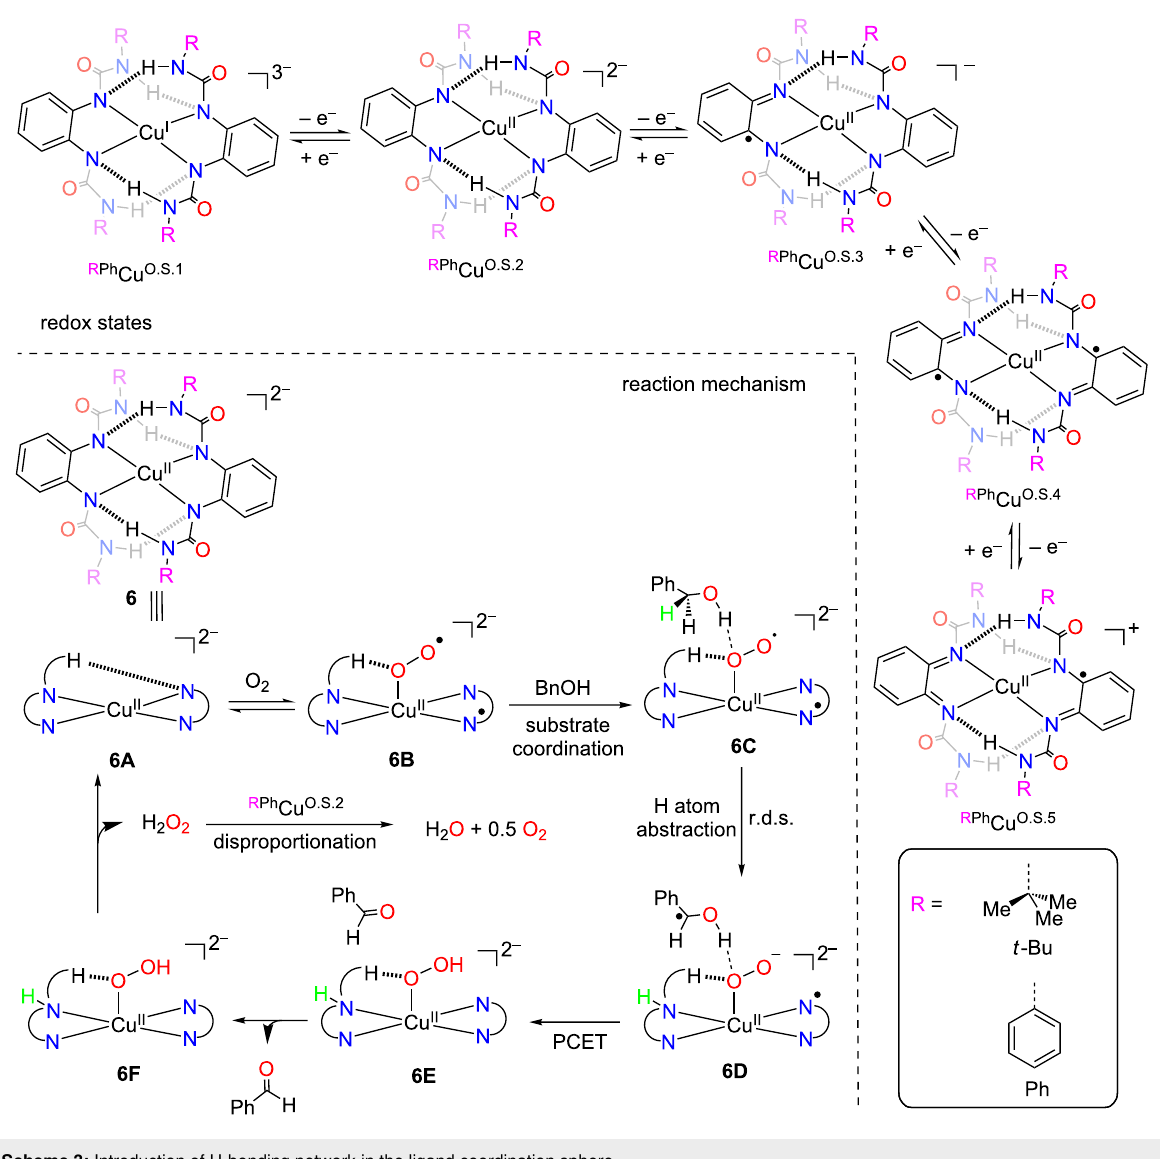
Scheme 3: Introduction of H-bonding network in the ligand coordination